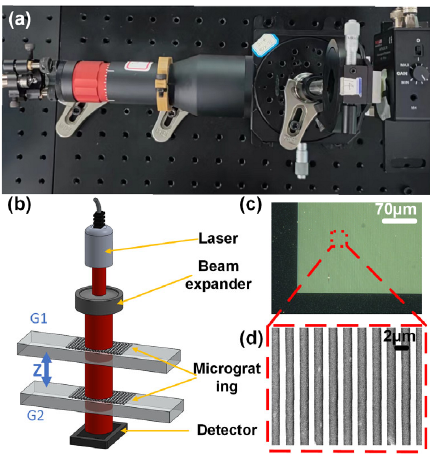
Figure 8. ( a ) Optical image of the experimental setup. ( b ) Schematic diagram of the proposed sensor. ( c ) Image of the micrograting used in the experiment from an optical microscope. ( d ) Image of the micrograting from a scanning electron microscope.